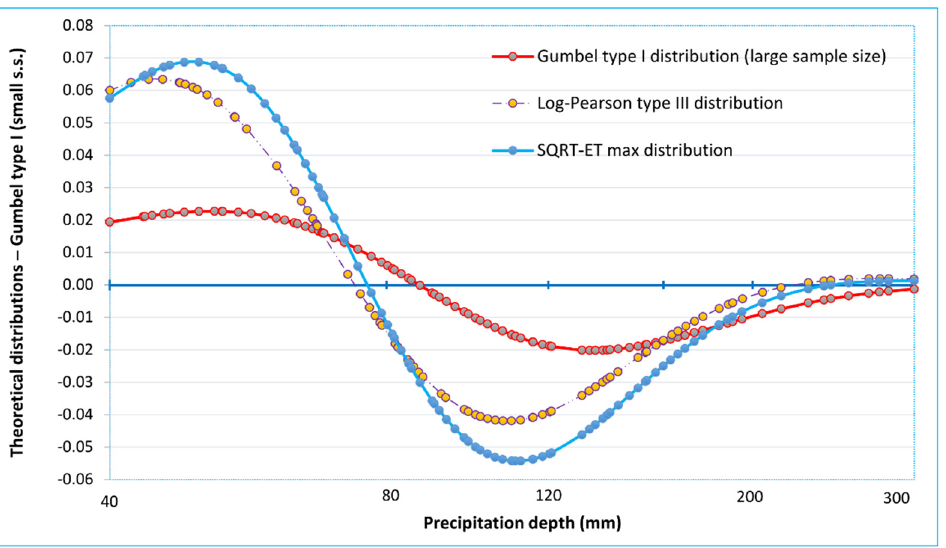
Figure 9. Differences between theoretical distributions with respect to Gumbel type I with a small sample size (small s.s.), as a reference, against precipitation depth. Log scale is used for horizontal axis.